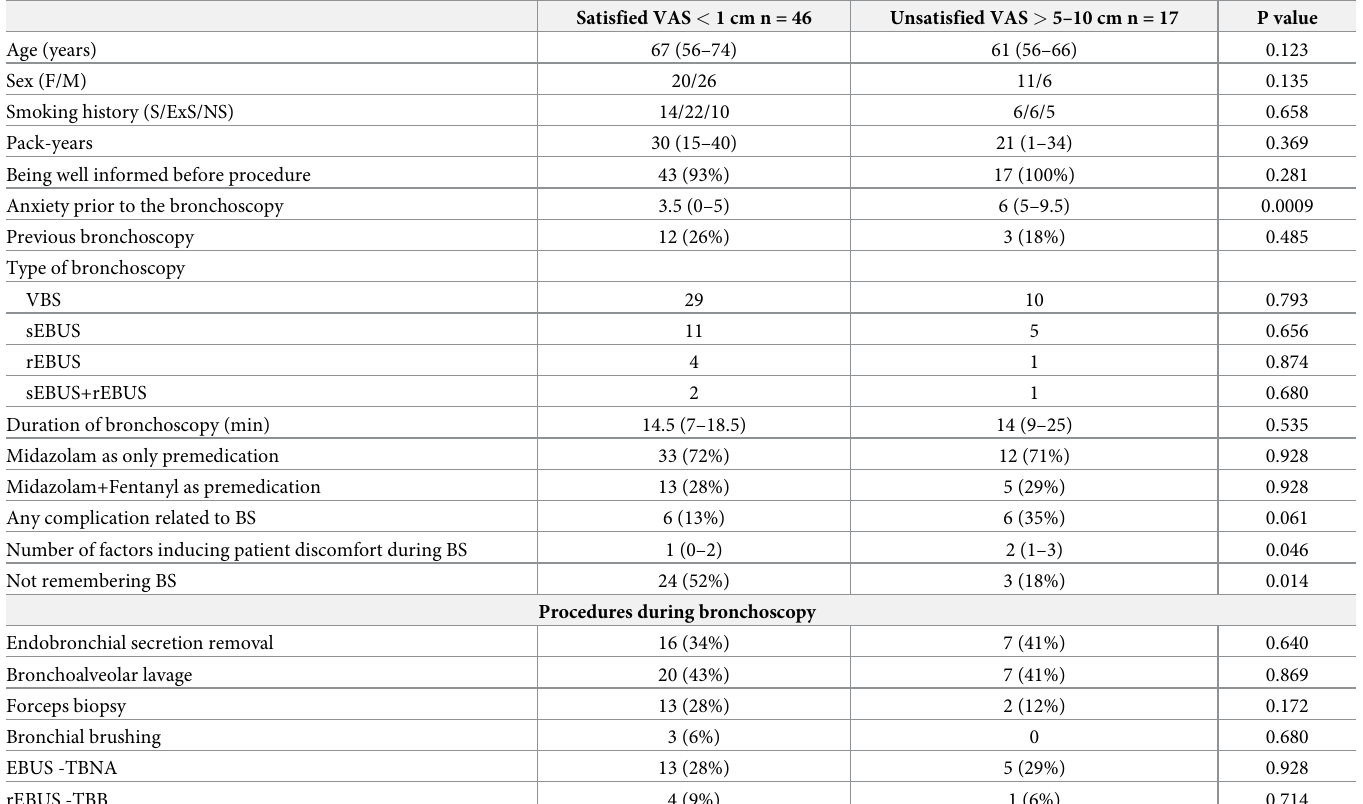
Table 4. Differences between satisfied and unsatisfied